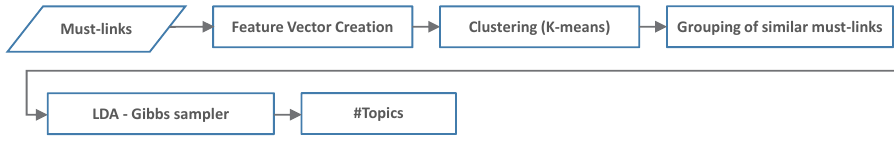
Figure 8. Work flow of integrating must-link into the Gibbs sampler.